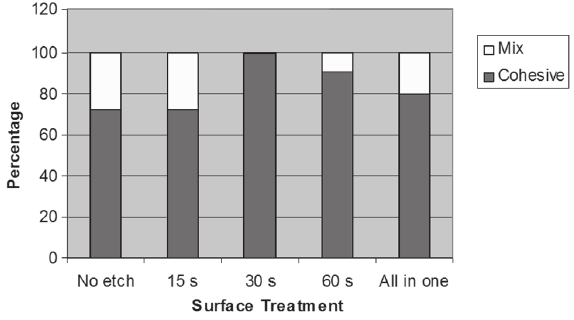
Figure 5- Fracture modes of the specimens bonded to Photac Fil Quick Applicap according to various surface treatment modalities